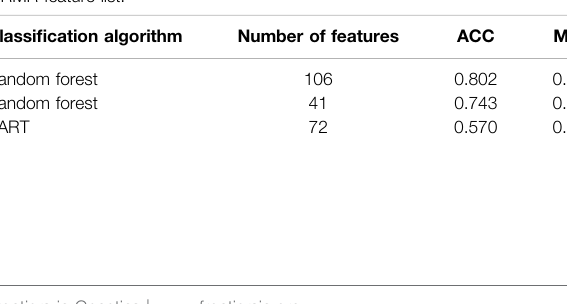
TABLE 2 | Performance of key classi fi ers with different algorithms based on the mRMR feature